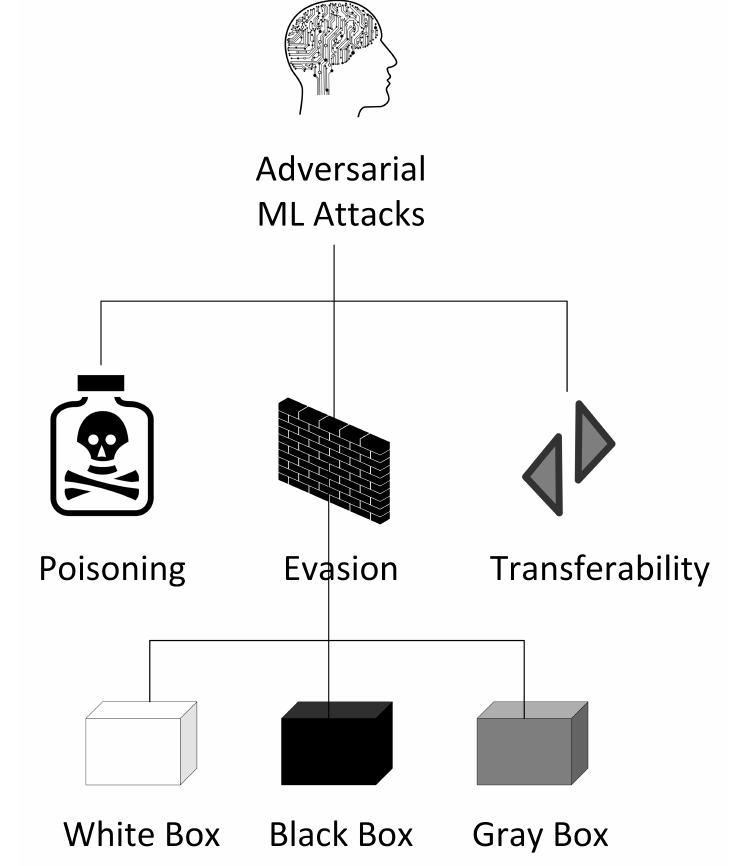
Figure 3. Common adversarial machine learning